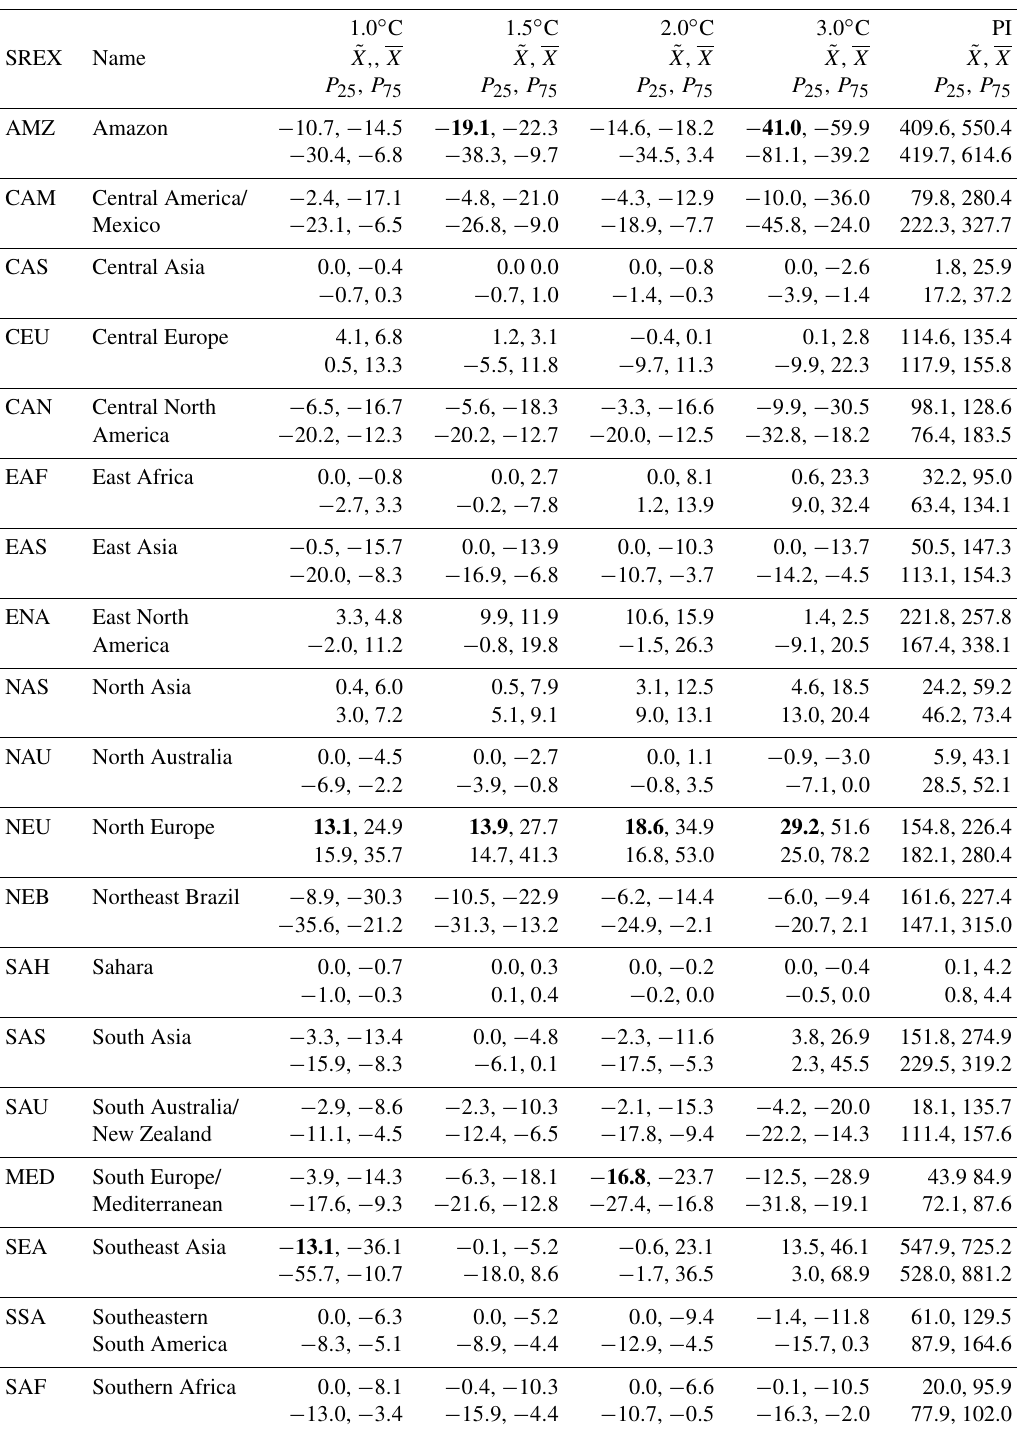
Table 3. Median ( ˜ X ), mean ( X ), P 25 , and P 75 of absolute GWR change (mmyr − 1 ) for four warming levels for each SREX region compared to PI. ˜ X , X , P 25 , and P 75 describe the distribution of changes of spatially averaged GWR in each SREX region among all 36–84 ensemble members (Sect. 2.3). P 25 / 75 are the 25th and 75th percentile in the ensemble for a given region and a given GW level. The last column shows absolute GWR at PI. The following regions are not included due to the coarse spatial resolution of the models and low confidence in the reliability of results: the Arctic, Canada, Greenland, and Iceland, Antarctica, the Pacific islands, the southern tropical Pacific, the small island region of the Caribbean, and the West Indian Ocean. Maximum and minimum values per GW level are given in bold. No statistical test is applied to filter the